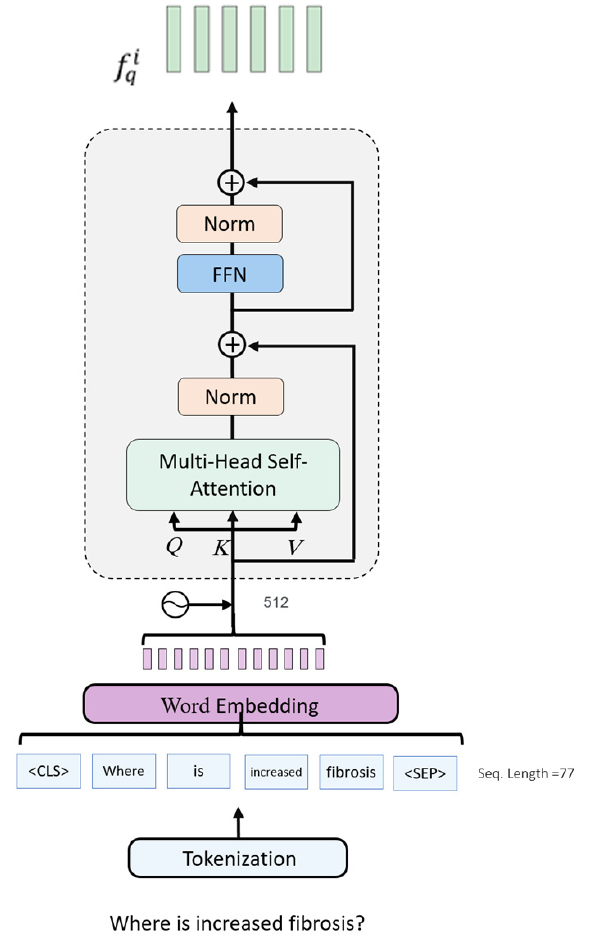
Figure 3. The architecture of the text encoder.